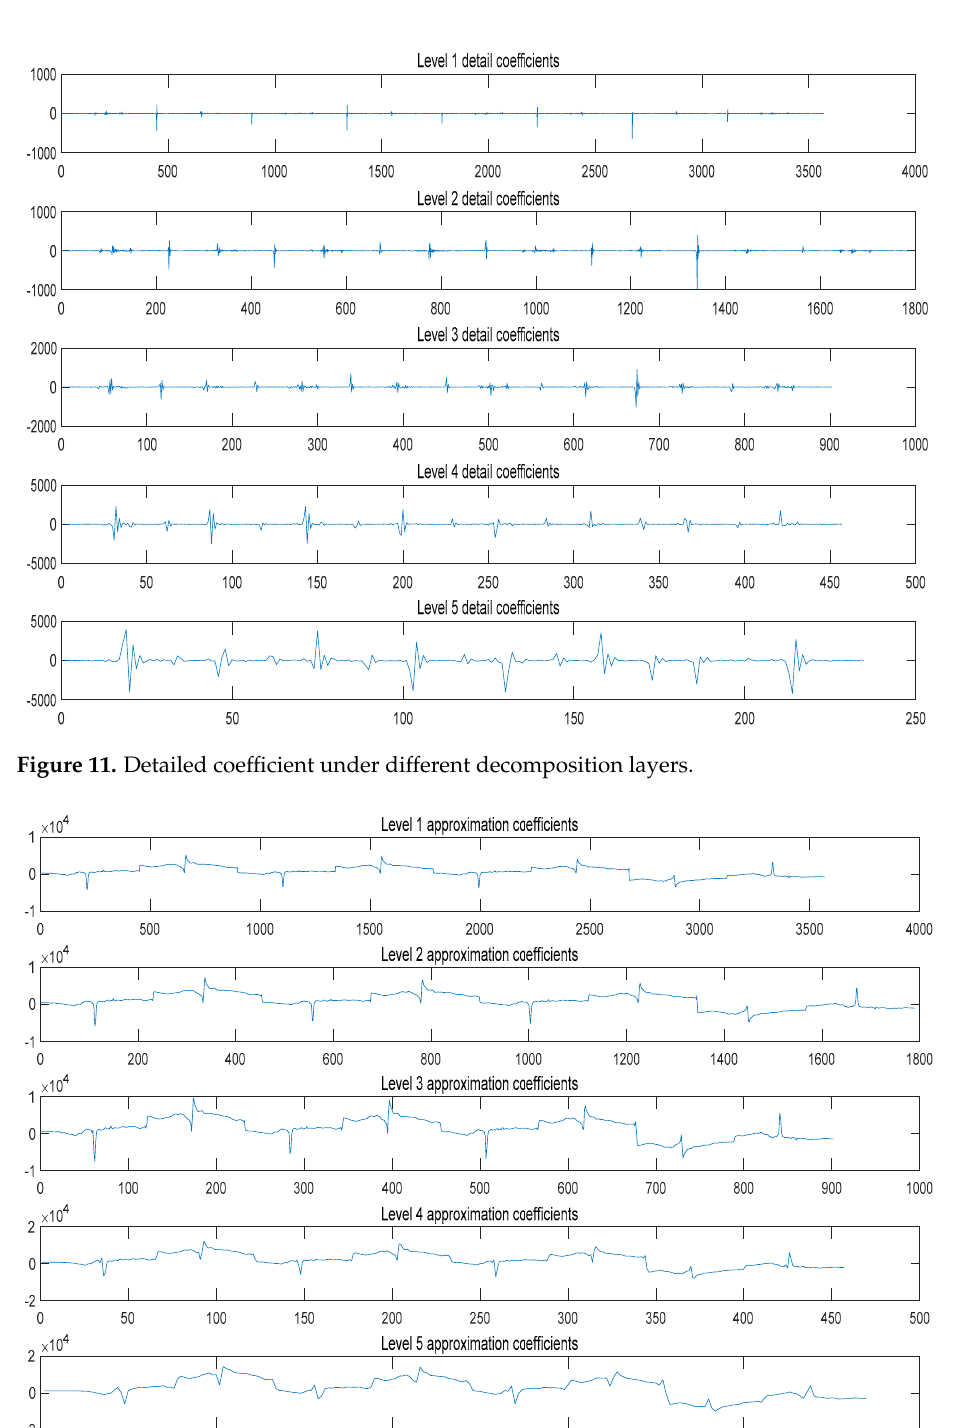
Figure 10. Denoised signals with different decomposition levels. ( a ) 5 levels; ( b ) 6 levels; ( c ) 7 levels; ( d ) 8 levels; ( e ) 9 levels.